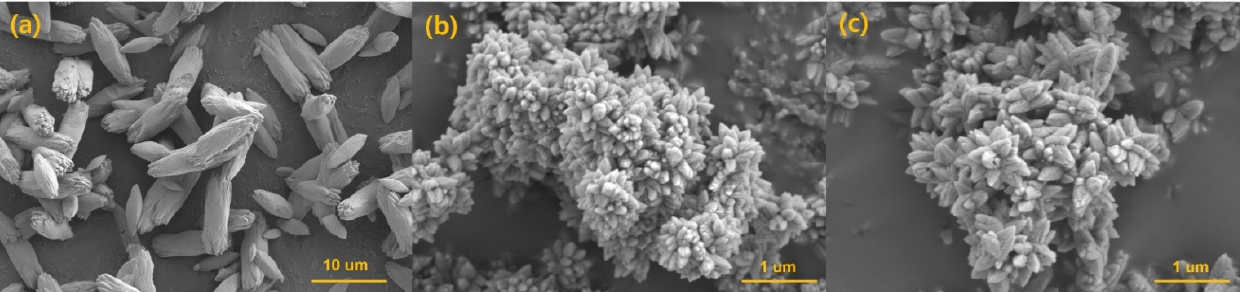
Figure 3. FE-SEM images of ( a ) SrMoO 4 , ( b ) SrMoO 4 :Tb 3+ , and ( c ) SrMoO 4 :Eu 3+ powders.